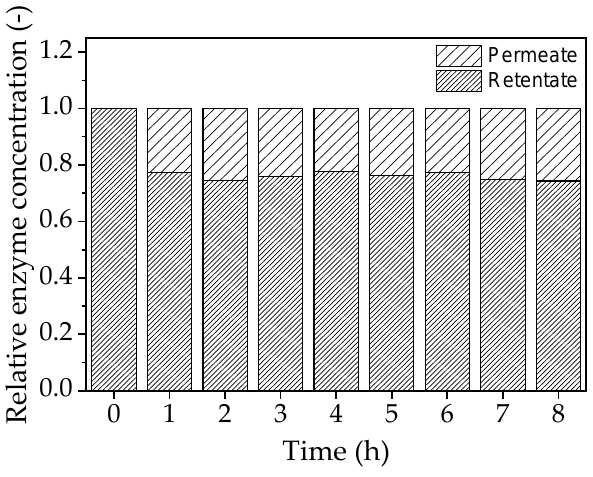
Figure 10. Relative enzyme concentration in the permeate and retentate determined by SDS-PAGE.